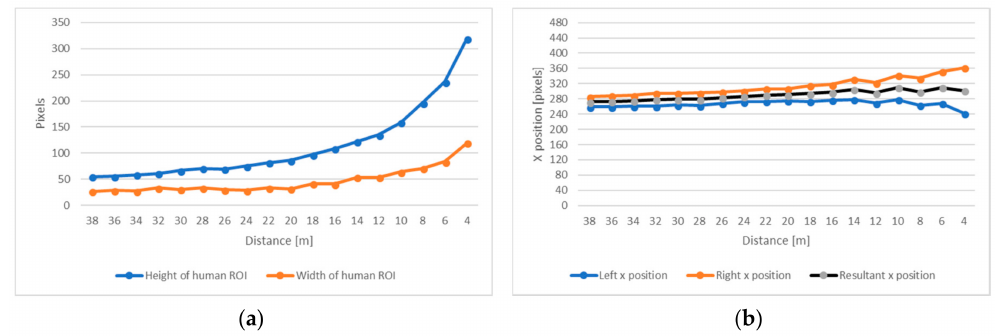
Figure 9. Results for human pose ROI presented on Figure 9a: ( a ) height and width of ROI, and ( b ) position on X of the